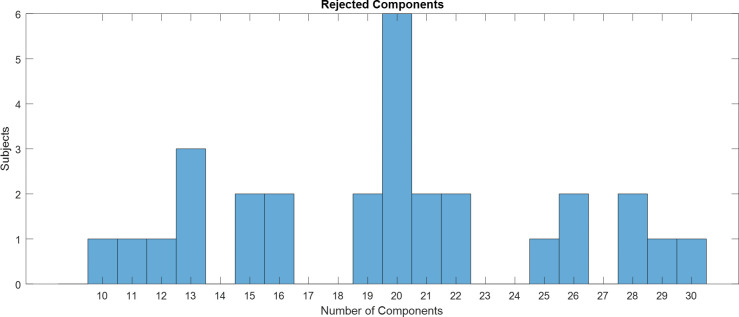
Histogram showing the distribution of the total number of rejected components based on detected muscle artifacts.